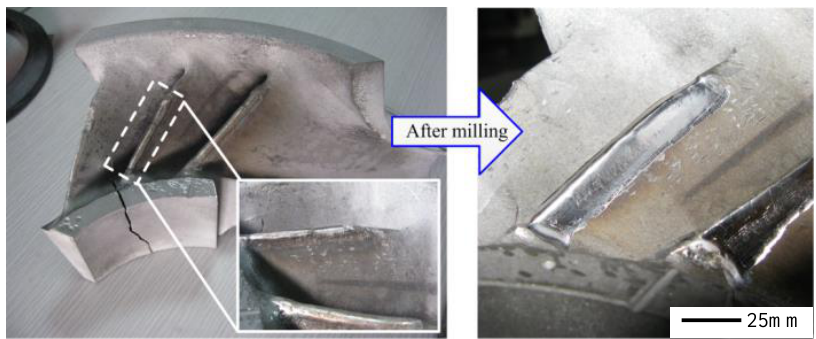
Figure 15. Repaired position before and after milling.